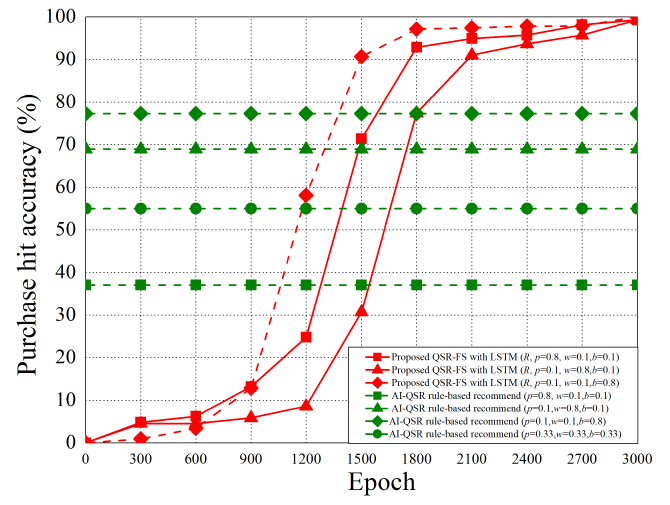
Figure 16. Purchase hit accuracy vs. per